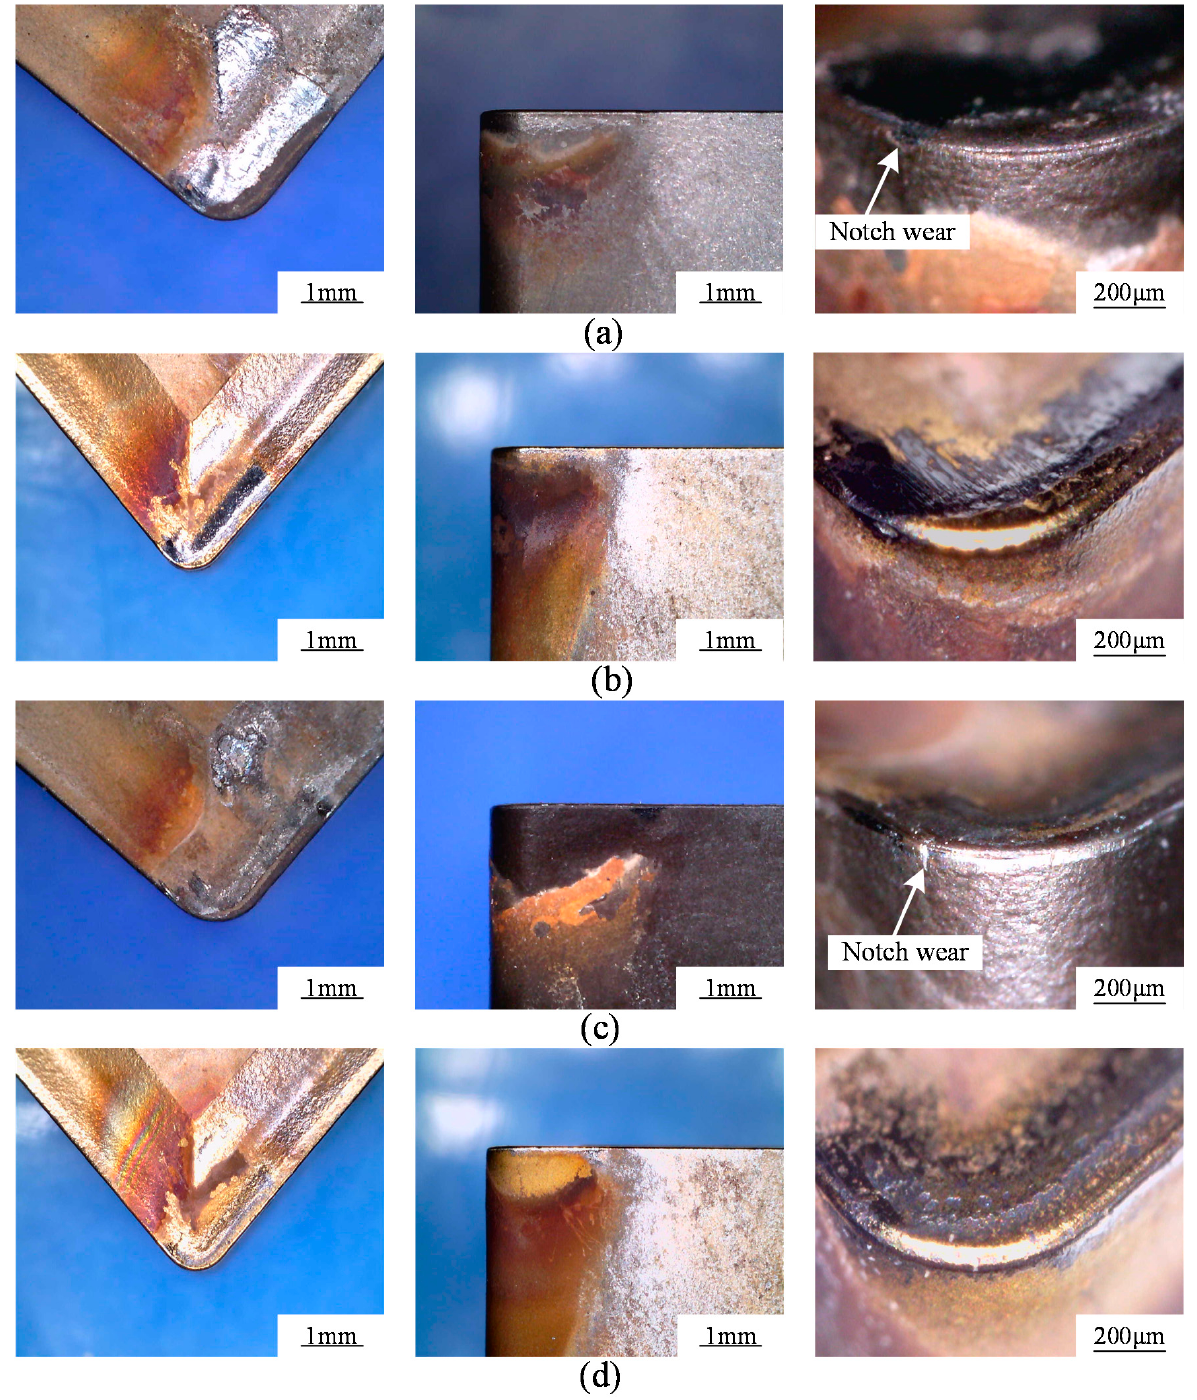
Figure 6. Wear morphologies of coated carbide tools at both cutting speeds: ( a ) UE6105 and ( b ) CA5535 at 40 m/min for 41 min, and ( c ) UE6105 and ( d ) CA5535 at 80 m/min for 15 min.